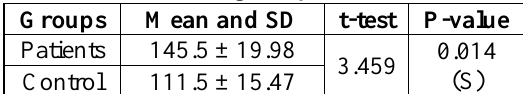
Table 5: The Mean and SD of saliva Anti-SSA in SSc (ng/ml) patients.